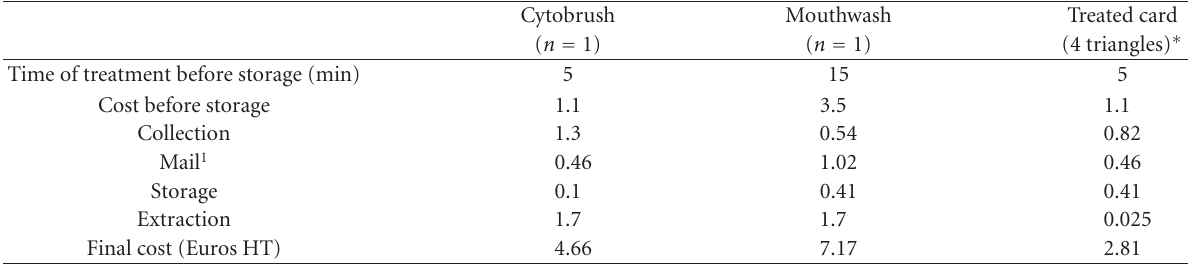
Table 4. Time of treatment before storage in minutes. Final cost (Euros) per sample according to the di ff erent steps of collection. Cytobrush Mouthwash Time of treatment before storage